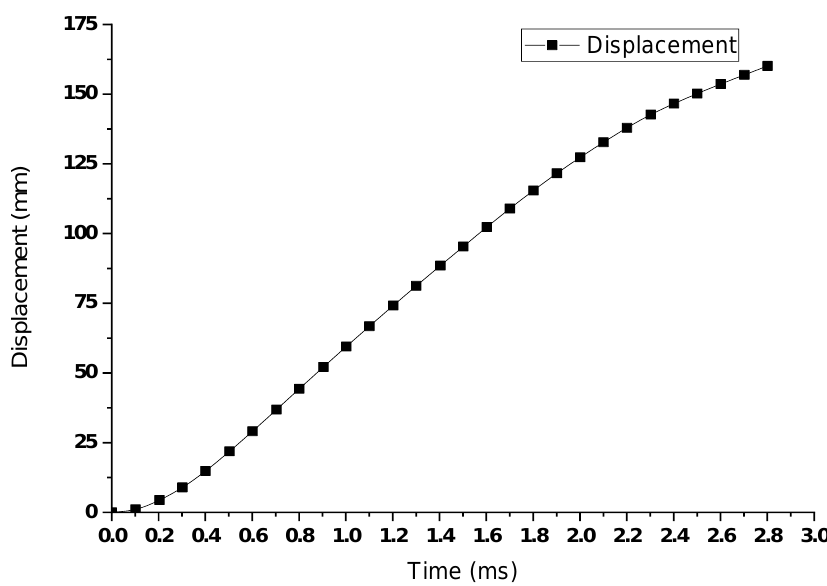
Figure 15. Deformations of the ferry from a side explosion due to 10 kg of TNT.